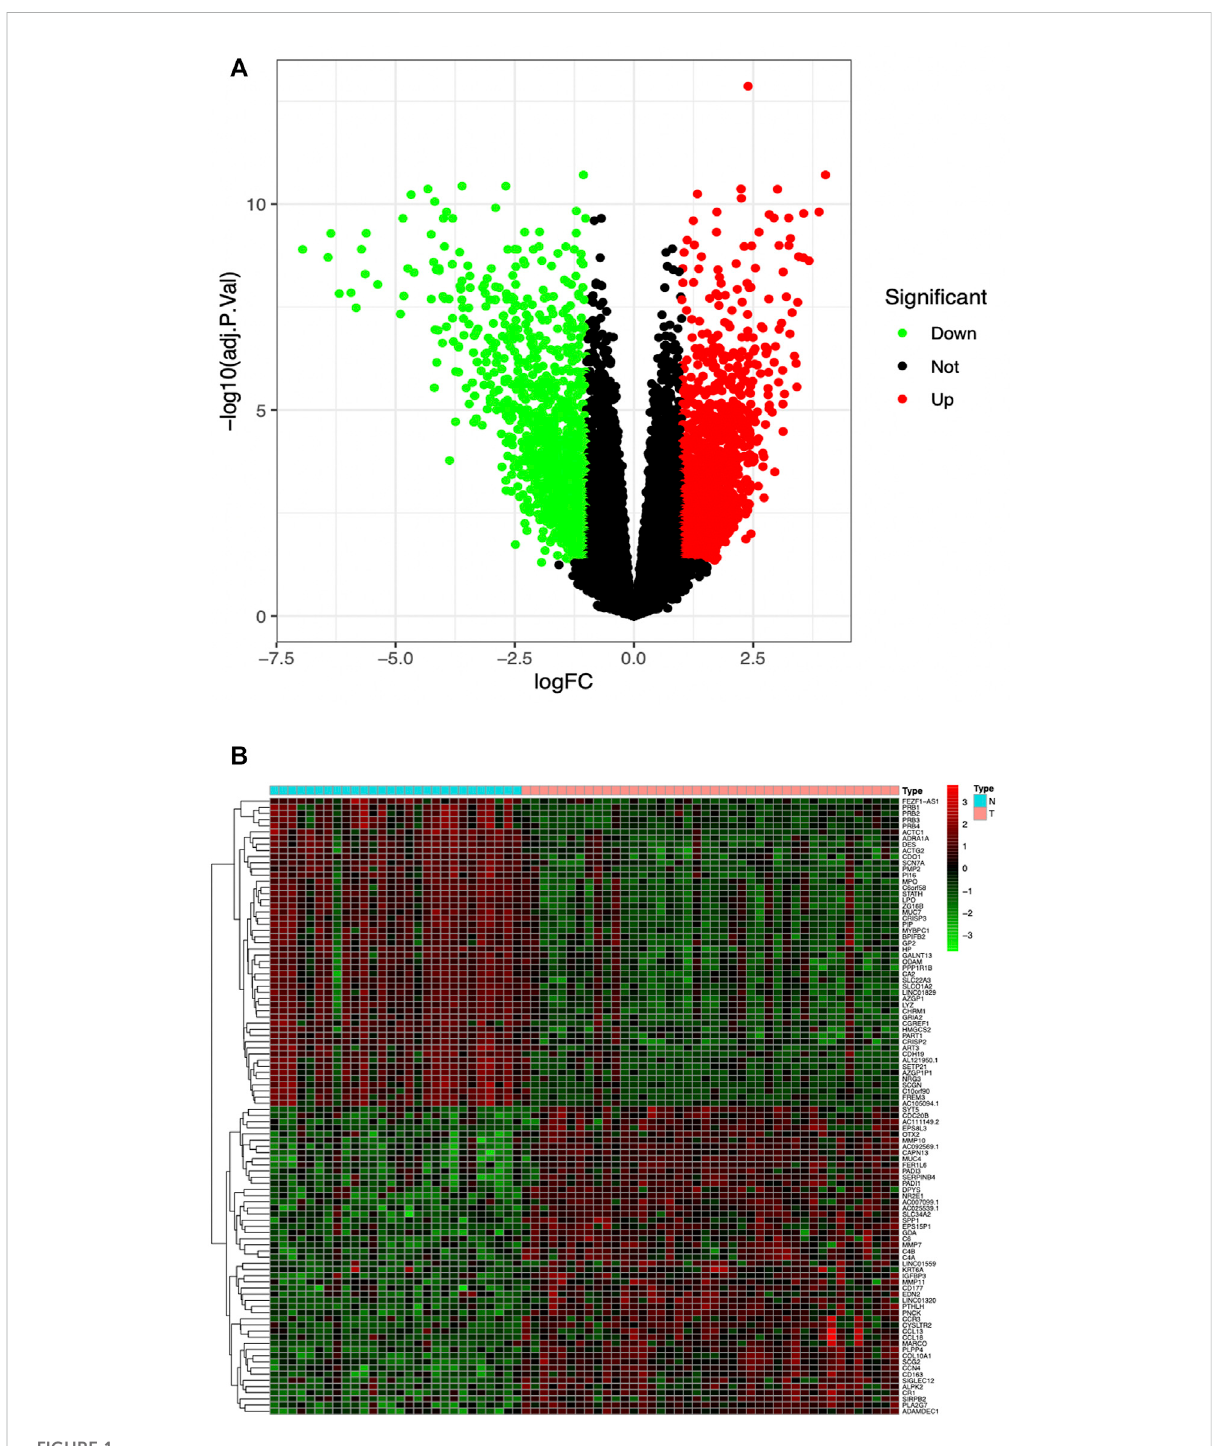
FIGURE 1 (A) Volcanoplotof2823DEGinGSE136825,RedDEGwithfoldchange > 2;greenDEGwithfoldchange < 2. (B) Heatmapofthetop-50DEGwith fold change > 2. Red upregulated DEG; green downregulated DEG. Small blue squares represent Normal group, the pink represent CRSwNP